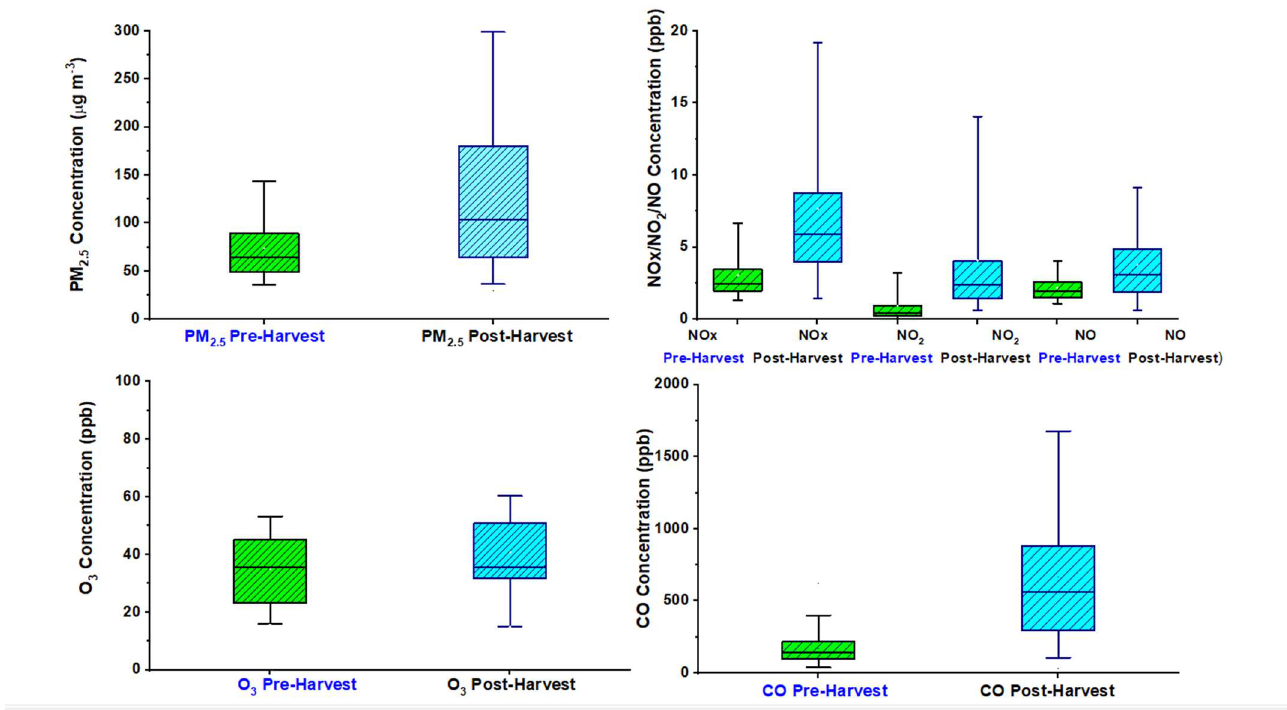
Figure 5. Box plots showing the variation of PM 2.5 and trace gases during the pre-harvest and post-harvest period .